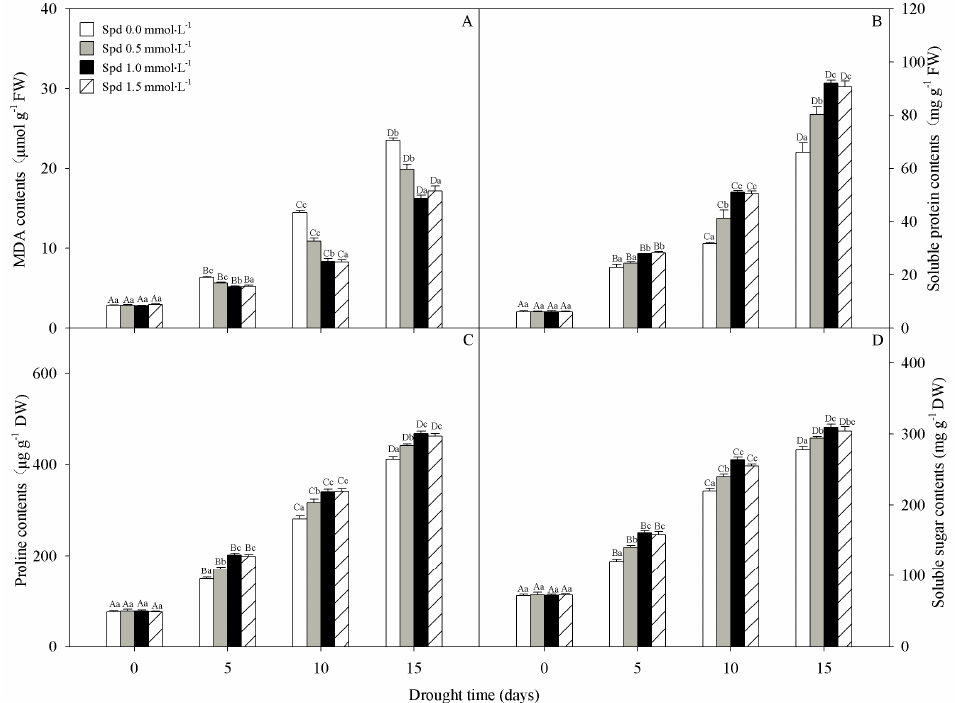
Figure 4. ( A ) Malondialdehyde (MDA), ( B ) soluble protein, ( C ) proline, and ( D ) soluble sugar contents of Hordeum jubatum shoots not Spd treated (S0) or pretreated with 0.5 mM Spd (S1), 1.0 mM Spd (S2), and 1.5 mM Spd (S3) under drought stress. Days 0, 5, 10, and 15 correspond to CK, D1, D2, and D3 in the experimental treatment, respectively. The capital letters denote significant differences among the different drought intensities from the shoots under the same concentrations of Spd. The small letters denote significant differences among the different concentrations of Spd from shoots under the same drought intensity. The differences in each parameter were tested by a one − way analysis of variance (ANOVA) at the p < 0.05 level. The bars represent the means ± SEs (n = 3). The soluble protein, proline, and soluble sugar contents of the H. jubatum